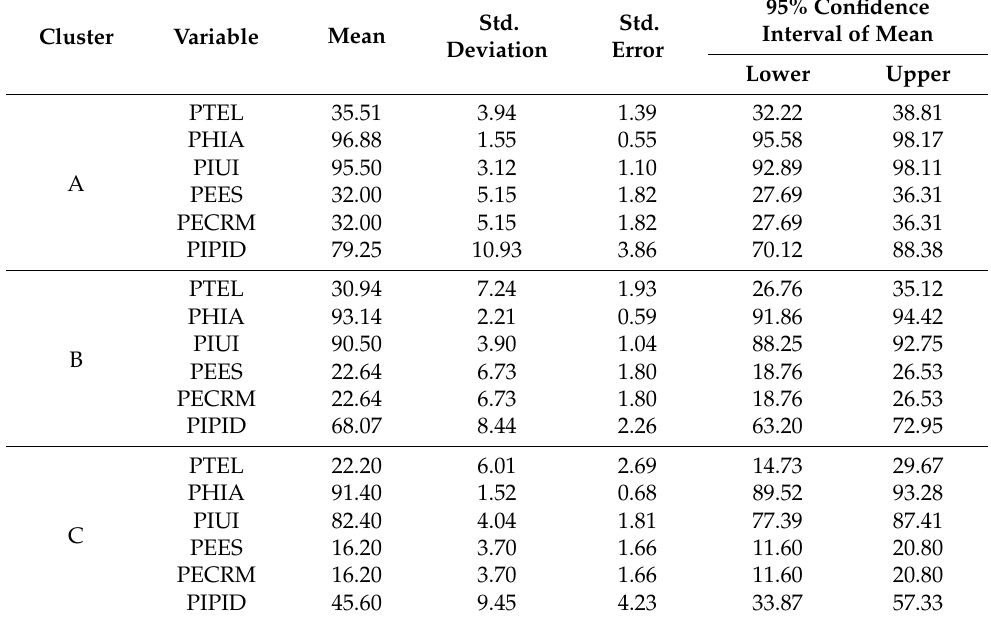
Table 9. Average characteristics of groups according to level of development of Internet purchases in 2021.